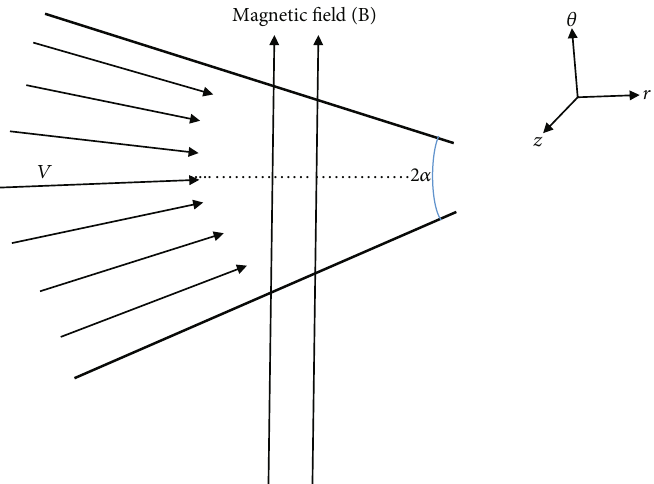
Figure 1: Flow geometry for a laminar fl ow in the radial